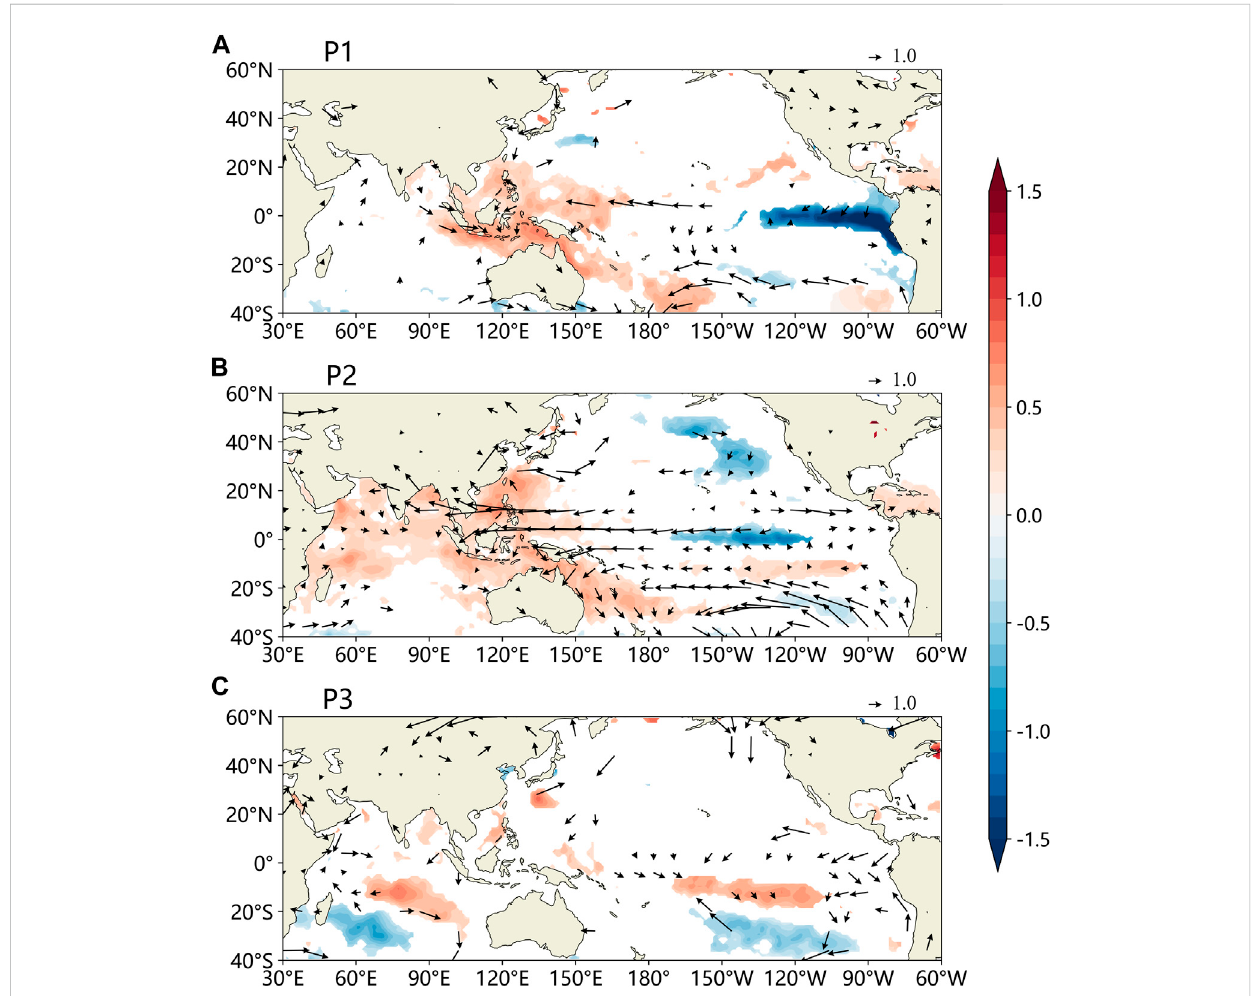
FIGURE 6 Regression coef fi cient of the previous autumn IOD index projected to the SSTA (shadows; Unit: ° C) and 850 hPa wind anomalies (vector; Unit: m/s) in the summer during (A) P1, (B) P2 and (C)